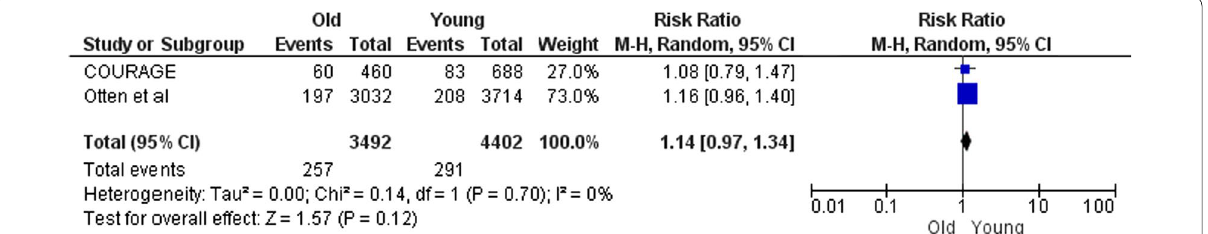
Fig. 10 Myocardial infraction after PCI in old versus young